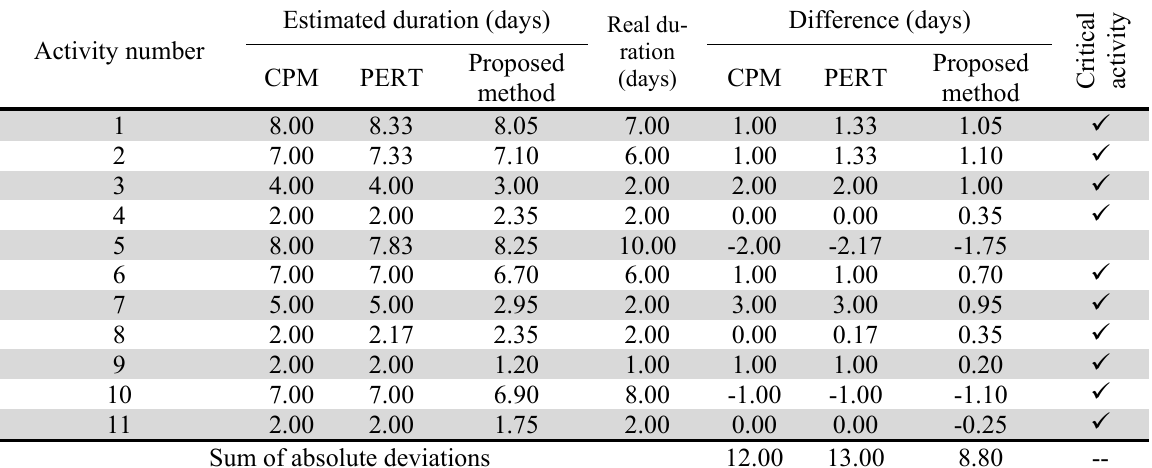
Fig. 3. Comparing the performance of methods for estimat- ing